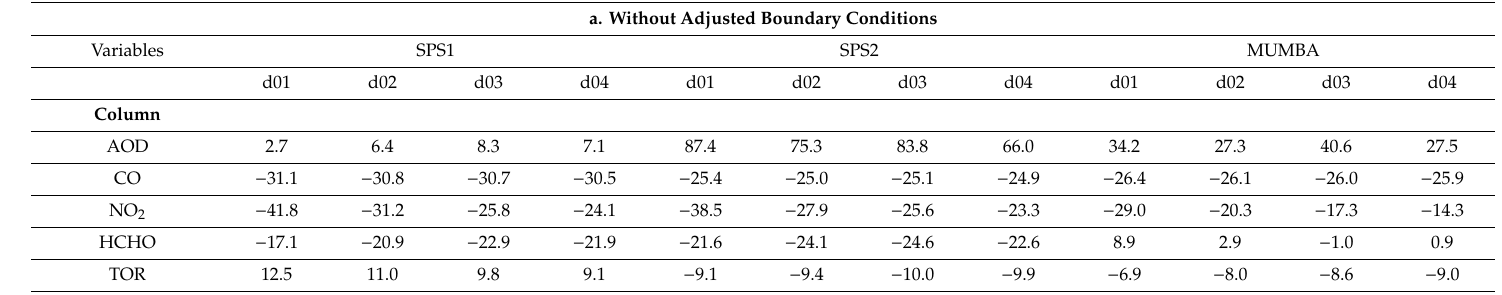
Figure 11. Observed and simulated surface concentrations of O 3 and PM 2.5 at selected sites during MUMBA. Two sets of simulation results at 3 km are compared, one from WRF/Chem-NCSU and one from WRF/Chem-ROMS. Table 7. Normalized mean biases (NMBs) (%) of chemical predictions from WRF / Chem simulations without (top) and with (bottom) adjusted boundary conditions at 81 km (d01), 27 km (d02), 9 km (d03), and 3 km (d04) over the 3 km domain (d04).